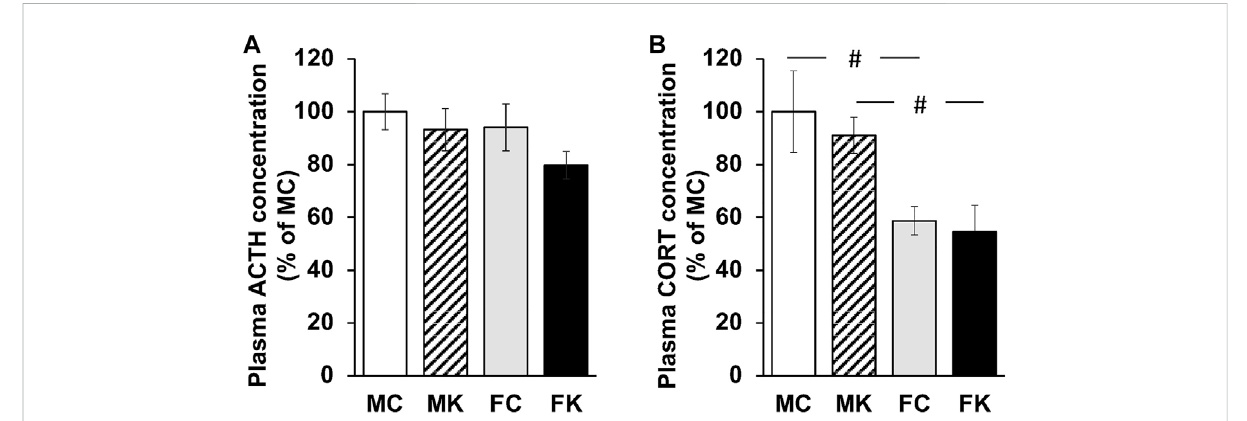
FIGURE 2 Plasma ACTH concentration (A) and Plasma CORT concentration (B) 30 min after subcutaneous injection of 2% formalin. The data are presented as the mean ± standard error of the mean. # p < 0.05 compared between male and female rats. ACTH, adrenocorticotropic hormone; CORT, corticosterone; MC, male control group; MK, male Kamikihi-to-treated group; FC, female control group; FK, female Kamikihi-to-treated